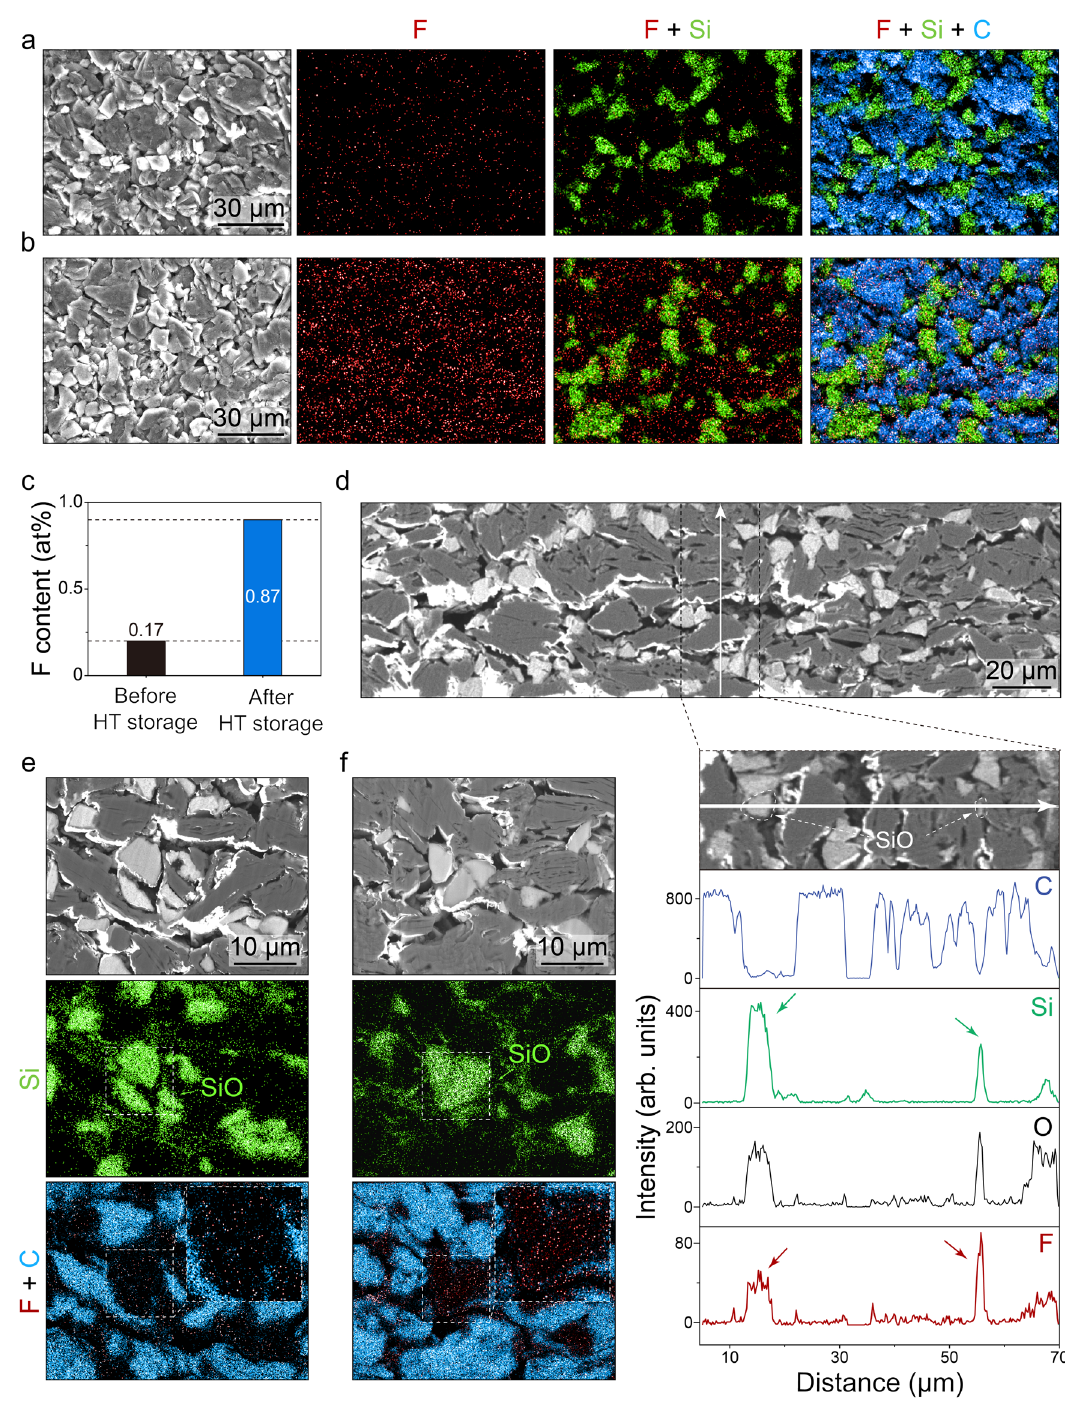
Fig.3|Fluorineincrementoftheanodesthroughthermalstorage.a – c Top-view SEM images and EDS elemental maps of graphite/SiO anode a before and b after 4 weeks of HT storage and c corresponding relative atomic ratios of fl uorine.